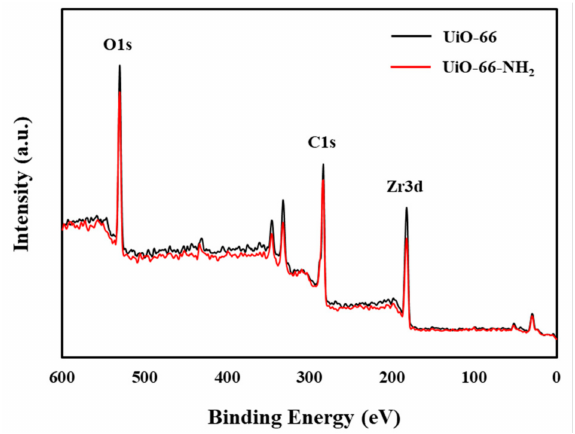
Figure 1. Complete XPS spectra of UiO-66 and UiO-66-NH 2